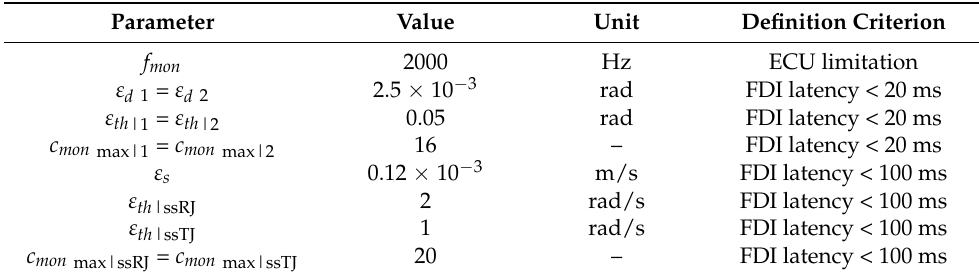
Table 5. Parameters of the Jamming Monitor